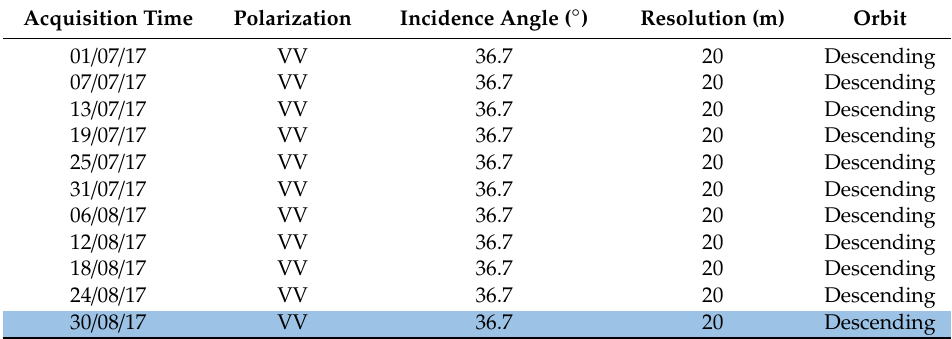
Table 1. Sentinel-1 intensity data used for the Houston case study (flood acquisition is marked in blue color).